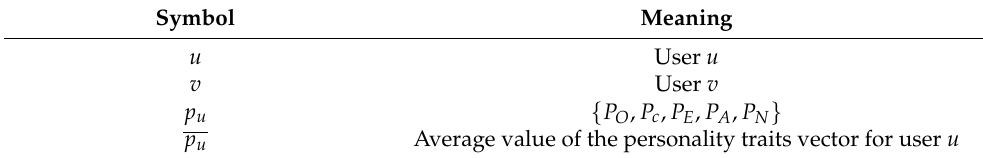
Table 2. Notation Used in Personality